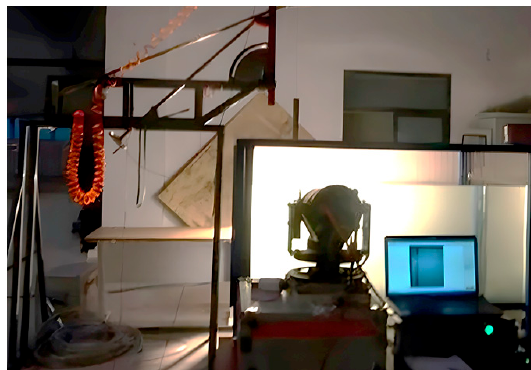
Figure 1. Projectile launcher.